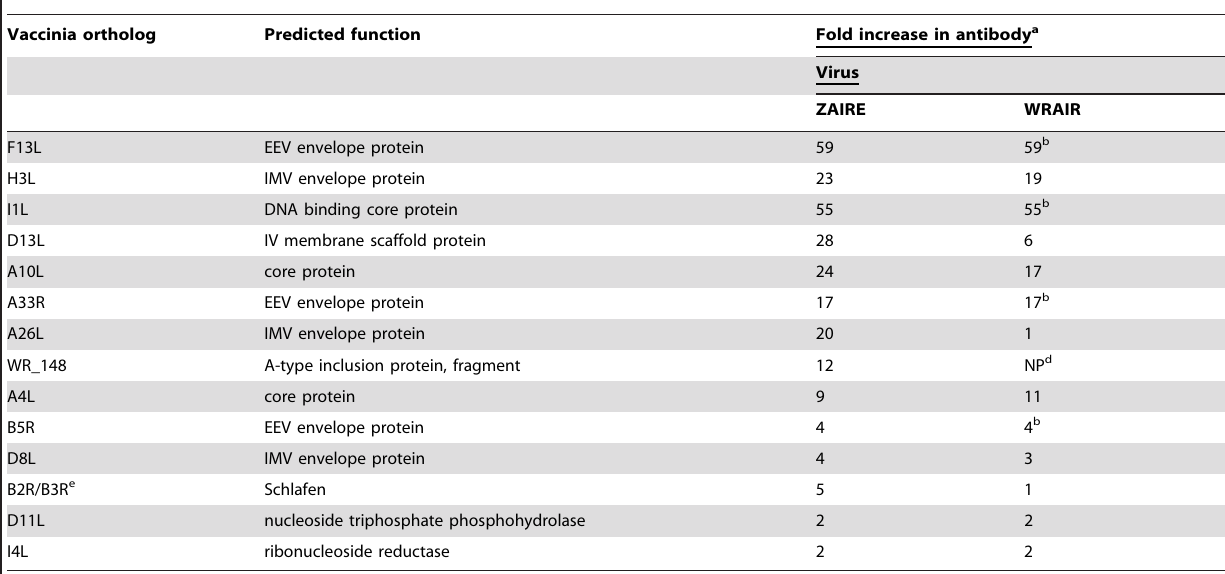
a Average signals in sera of vaccinated normalized to signals in normal sera. b 100% identity between WRAIR and ZAIRE proteins. c NA, not present in genome. d NP, not present on